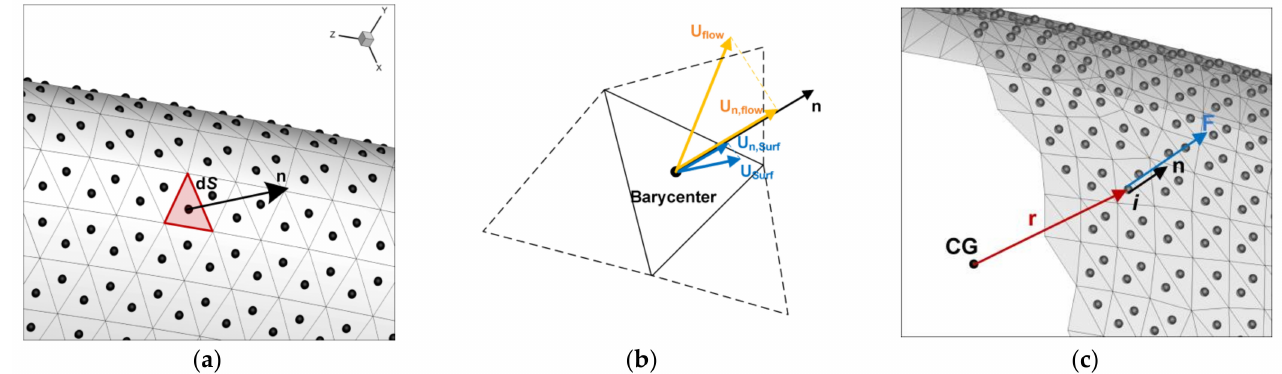
Figure 1. ( a ) Tessellated surface representation, ( b ) definition of the slip velocity, projected to the wall normal ( c ) Torque calculation, in respect to the center of gravity